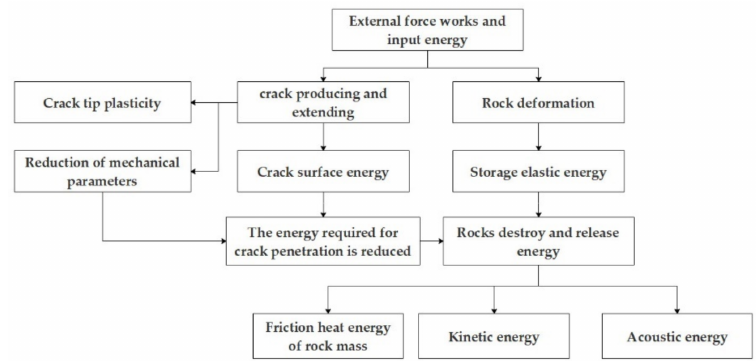
Figure 1. Transformation and transfer relations among various energies in the process of rock de-formation and